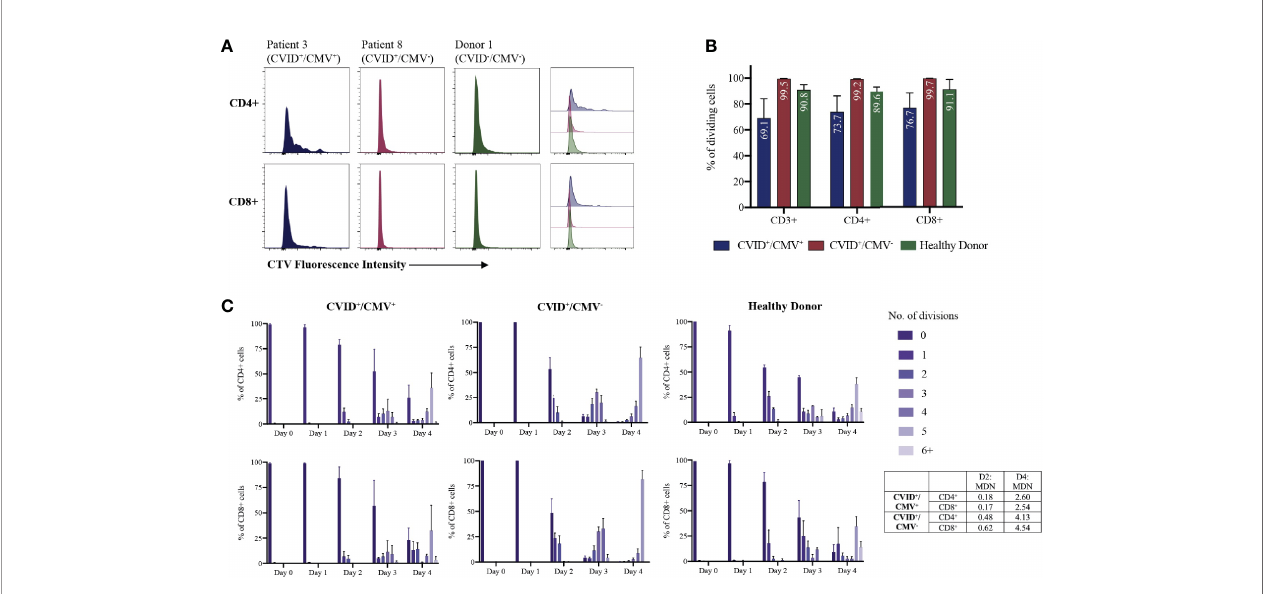
FIGURE 1 | T-cell proliferation to IL-2 + CD3/28 stimulation. (A) Individual examples of CD4 + and CD8 + T-cell proliferation at Day 4, determined by CellTrace Violet (CTV) dilution. (B) Proportions of dividing cells at Day 4 for each cohort, expressed as a percentage of total CD3 + , CD4 + and CD8 + T-cells. Results presented as means and standard errors of the mean (SEM). (C) T-cell proliferation over time: number of CD4 + and CD8 + divisions at each time-point, expressed as a percentage of total CD4 + and CD8 + T-cells. Results presented as means and SEM for each cohort. MDN, Mean Division